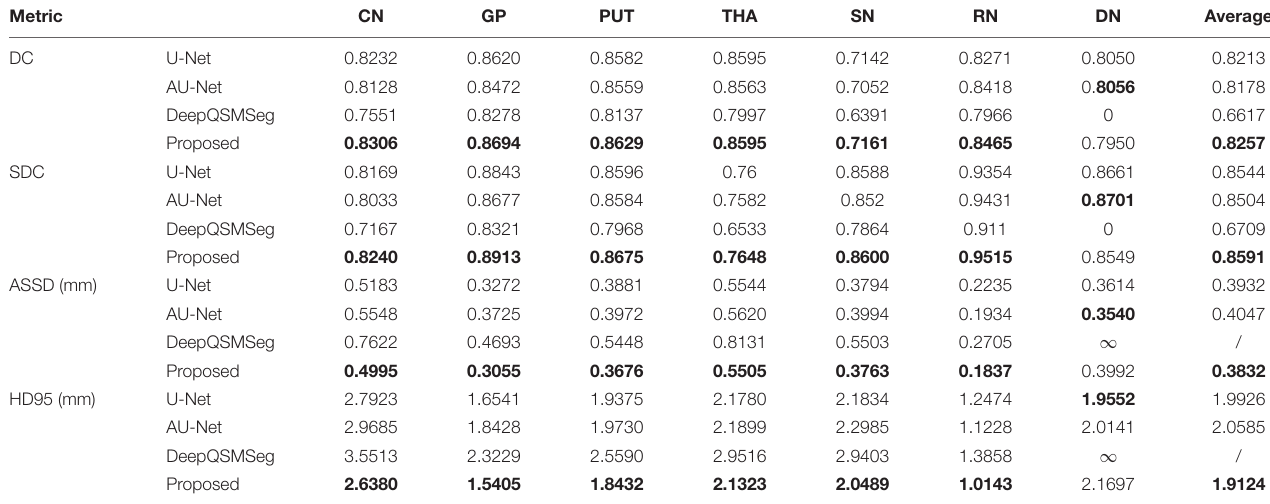
TABLE 2 | Numerical evaluation results on the test set.